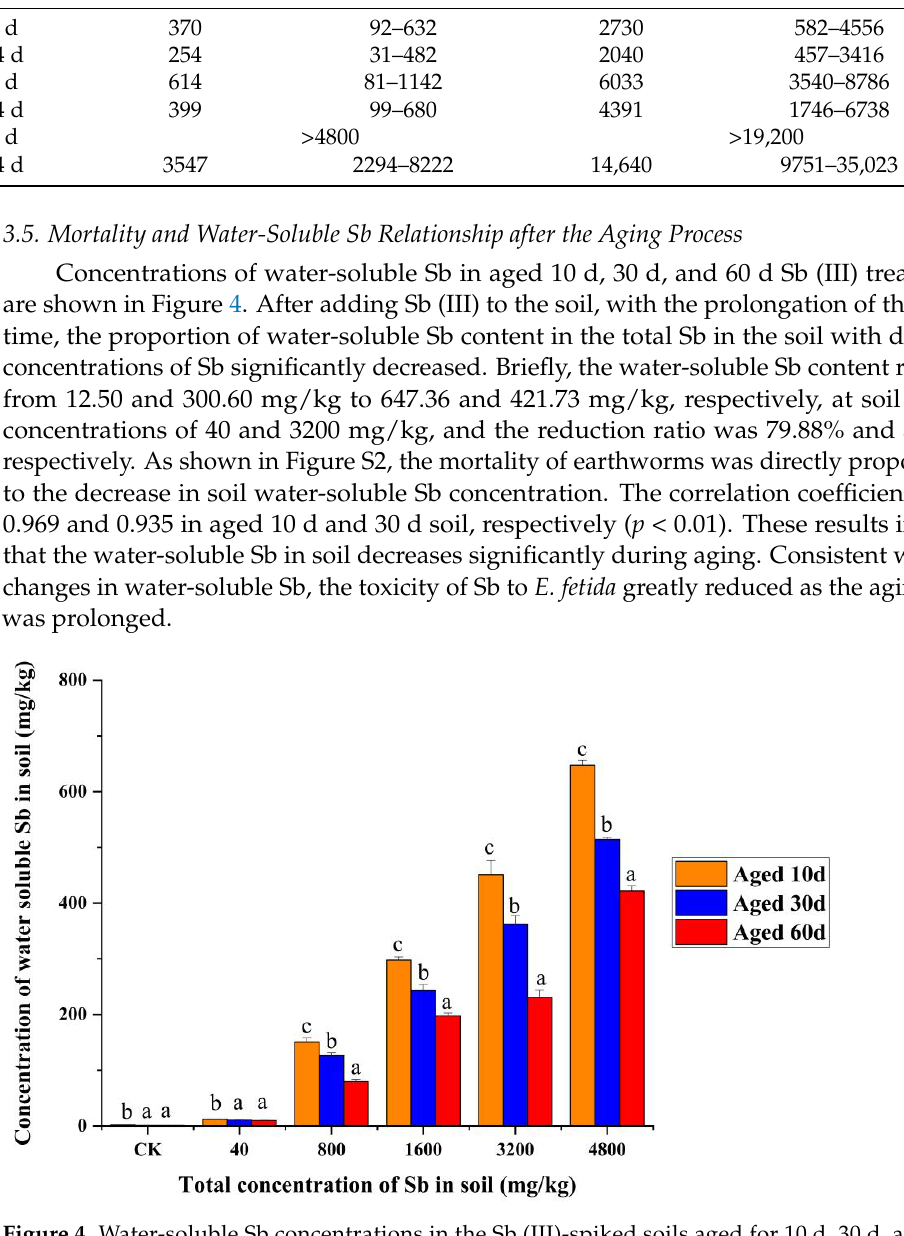
Figure 4. Water-soluble Sb concentrations in the Sb (III)-spiked soils aged for 10 d, 30 d, and 60 d. Error bars indicate the standard deviations ( n = 4). Bars with the different lowercase letter indicate significant differences between aging treatments at the same Sb concentration ( p < 0.05).